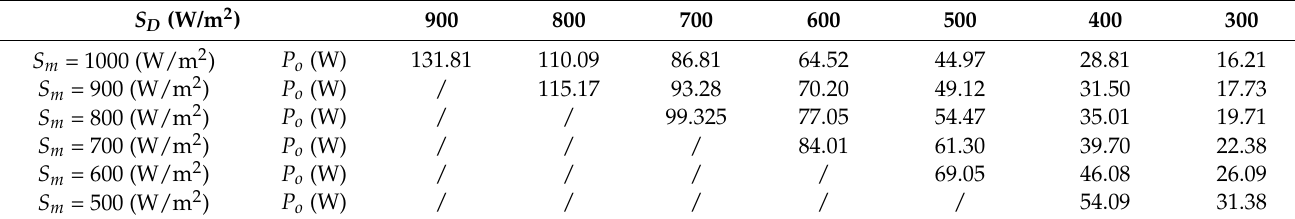
Table 5. Simulation results under decreasing irradiance